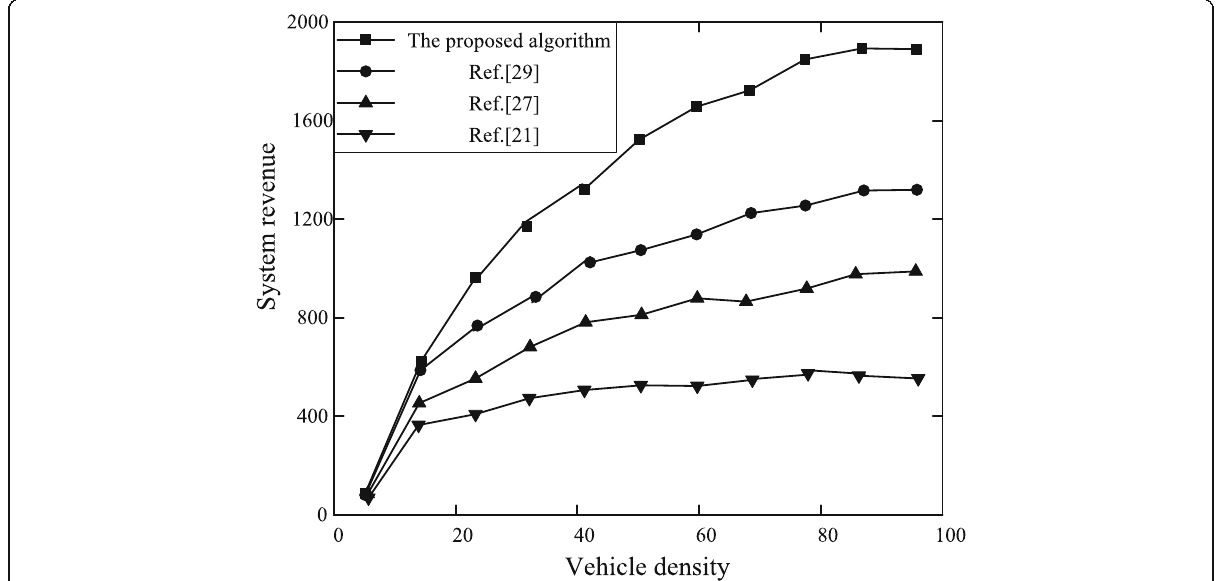
Fig. 11 Comparison for the revenue results of different algorithms under different vehicle